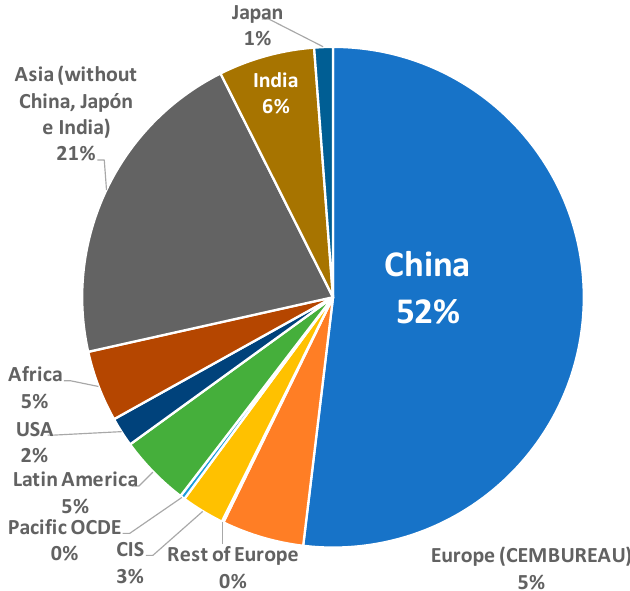
Figure 5. World cement production in 2016 by region and main countries (4.65 Gt) [4].